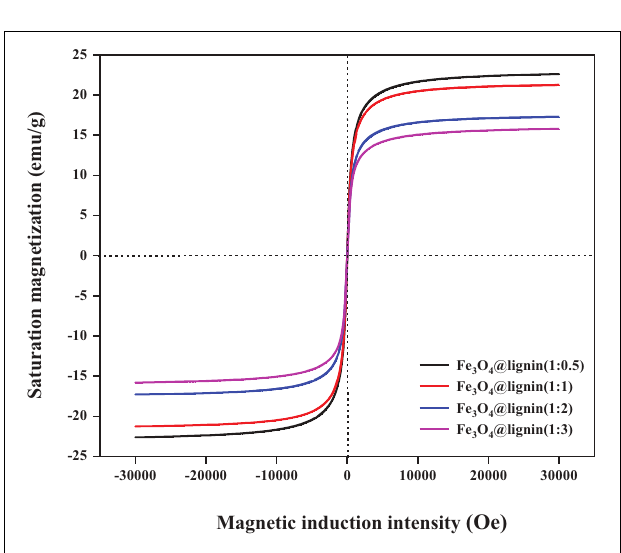
FIGURE 4 | Hysteresis curve of magnetic lignin